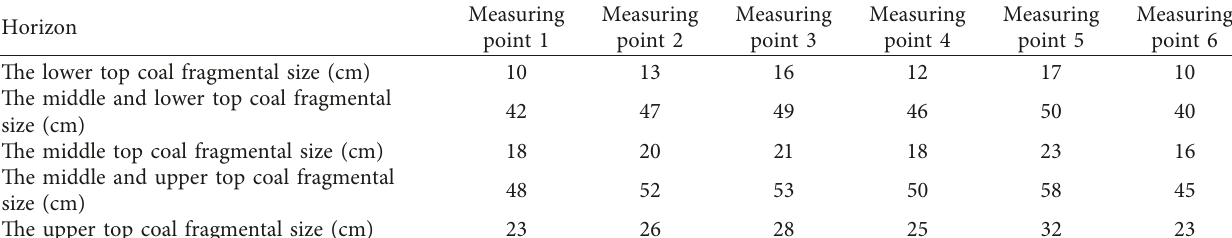
Table 4: Measured top coal block size.